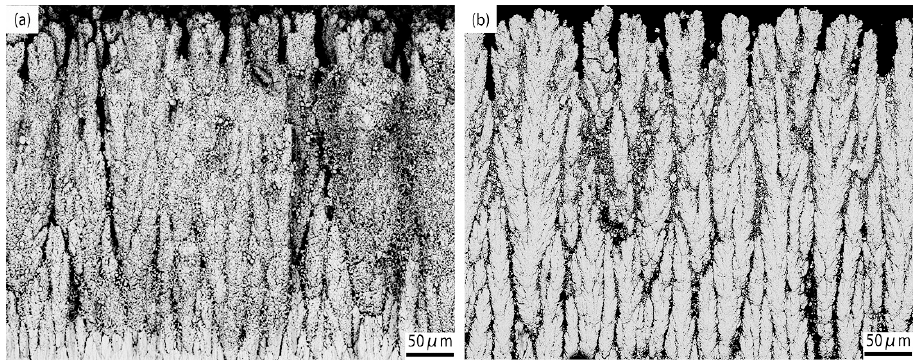
Figure 1. SEM micrographs of the as-sprayed PS–PVD TBCs: ( a ) fracture surface; ( b ) polished cross-section.